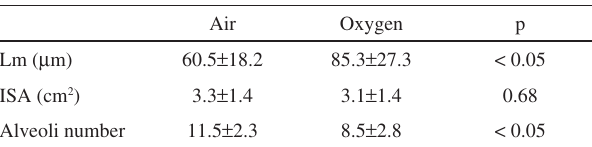
Table 2 - Mean linear intercept (Lm), internal surface area (ISA) and alveoli